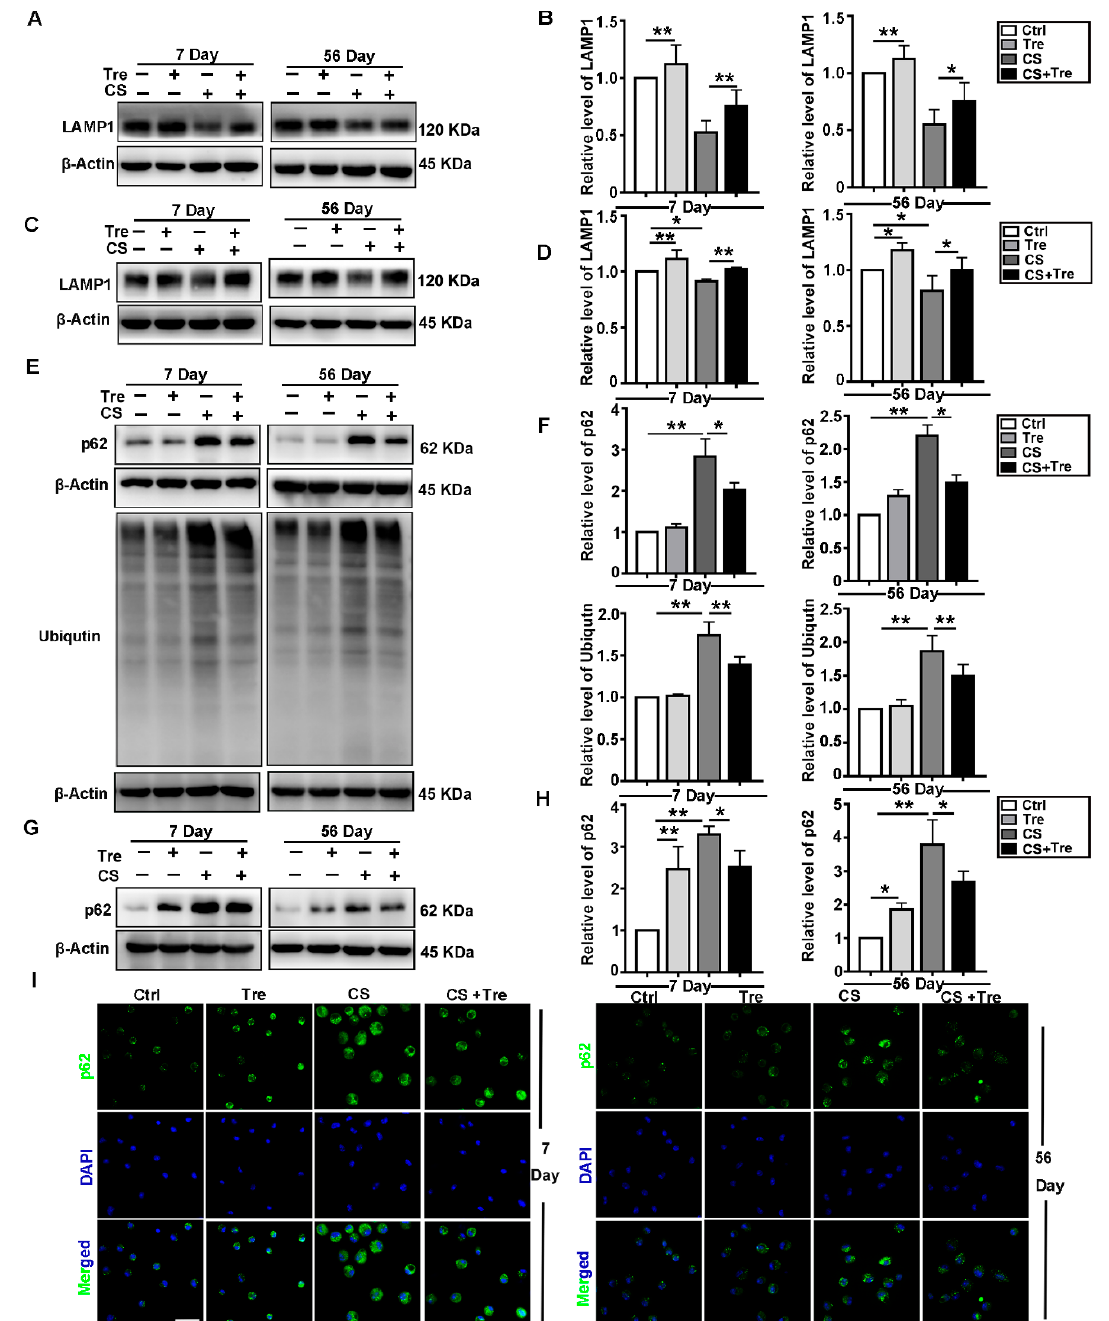
Figure 5. Tre relieves CS-induced lysosome damage and disorder of autophagic substrate degradation in vivo. ( A , B ) Immunoblotting analysis of LAMP1 protein levels in lung tissue on day 7 or 56 post CS instillation ( n = 5 to 6). ( C , D ) Immunoblotting analysis of LAMP1 protein levels in AMs on day 7 or 56 post CS instillation ( n = 3 to 4). ( E , F ) Immunoblotting analysis of p62 and ubiquitin protein levels in lung tissue on day 7 or 56 post CS instillation ( n = 5 to 6). ( G , H ) Immunoblotting analysis of p62 protein levels in AMs on day 7 or 56 post CS instillation ( n = 3 to 4). ( I ) Immunofluorescence analysis of p62 in AMs on day 7 or 56 post CS instillation (scale bar = 25 μ m and n = 3). Data are presented as the mean ± SD. *, p < 0.05 and **, p < 0.01.